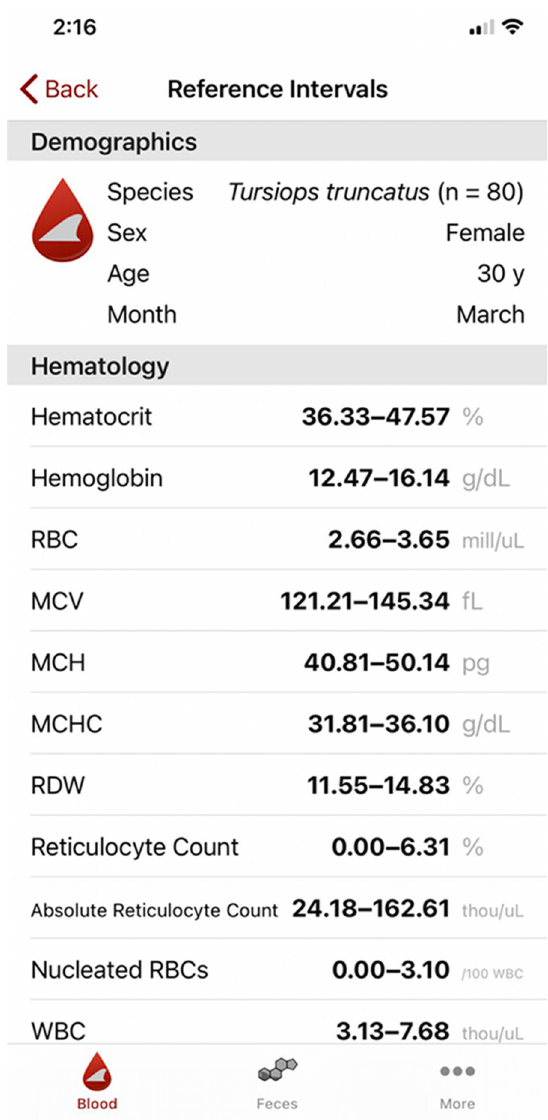
Fig 2. Screenshot taken on an iPhone device illustrating the user interface for the reference interval